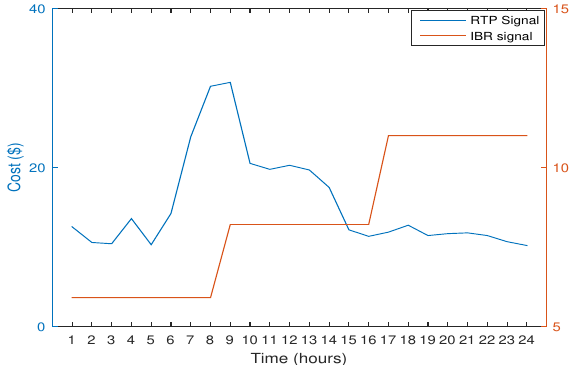
Figure 7. RTP and IBR pricing signal